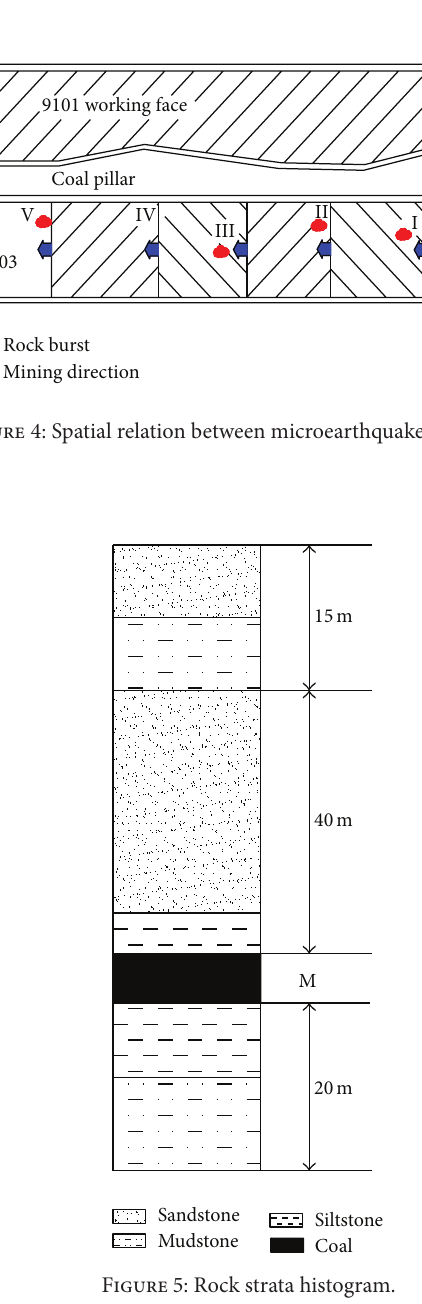
Table 2: Absorbed energy capacity scale for ground support.